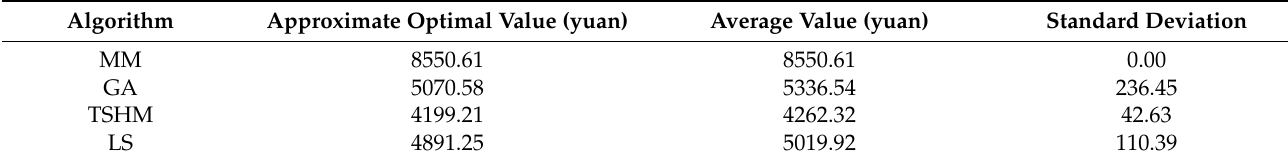
Table 2. Results obtained by manmade schedule (MM), GA, TSHM, and LS.